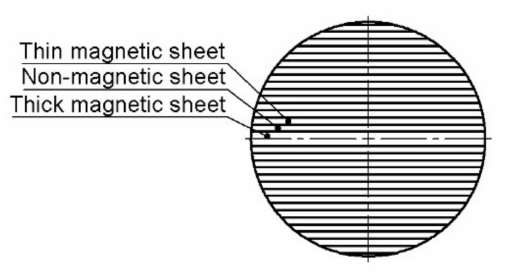
Figure 1. Cross section of ALA-SynRM rotor (according to